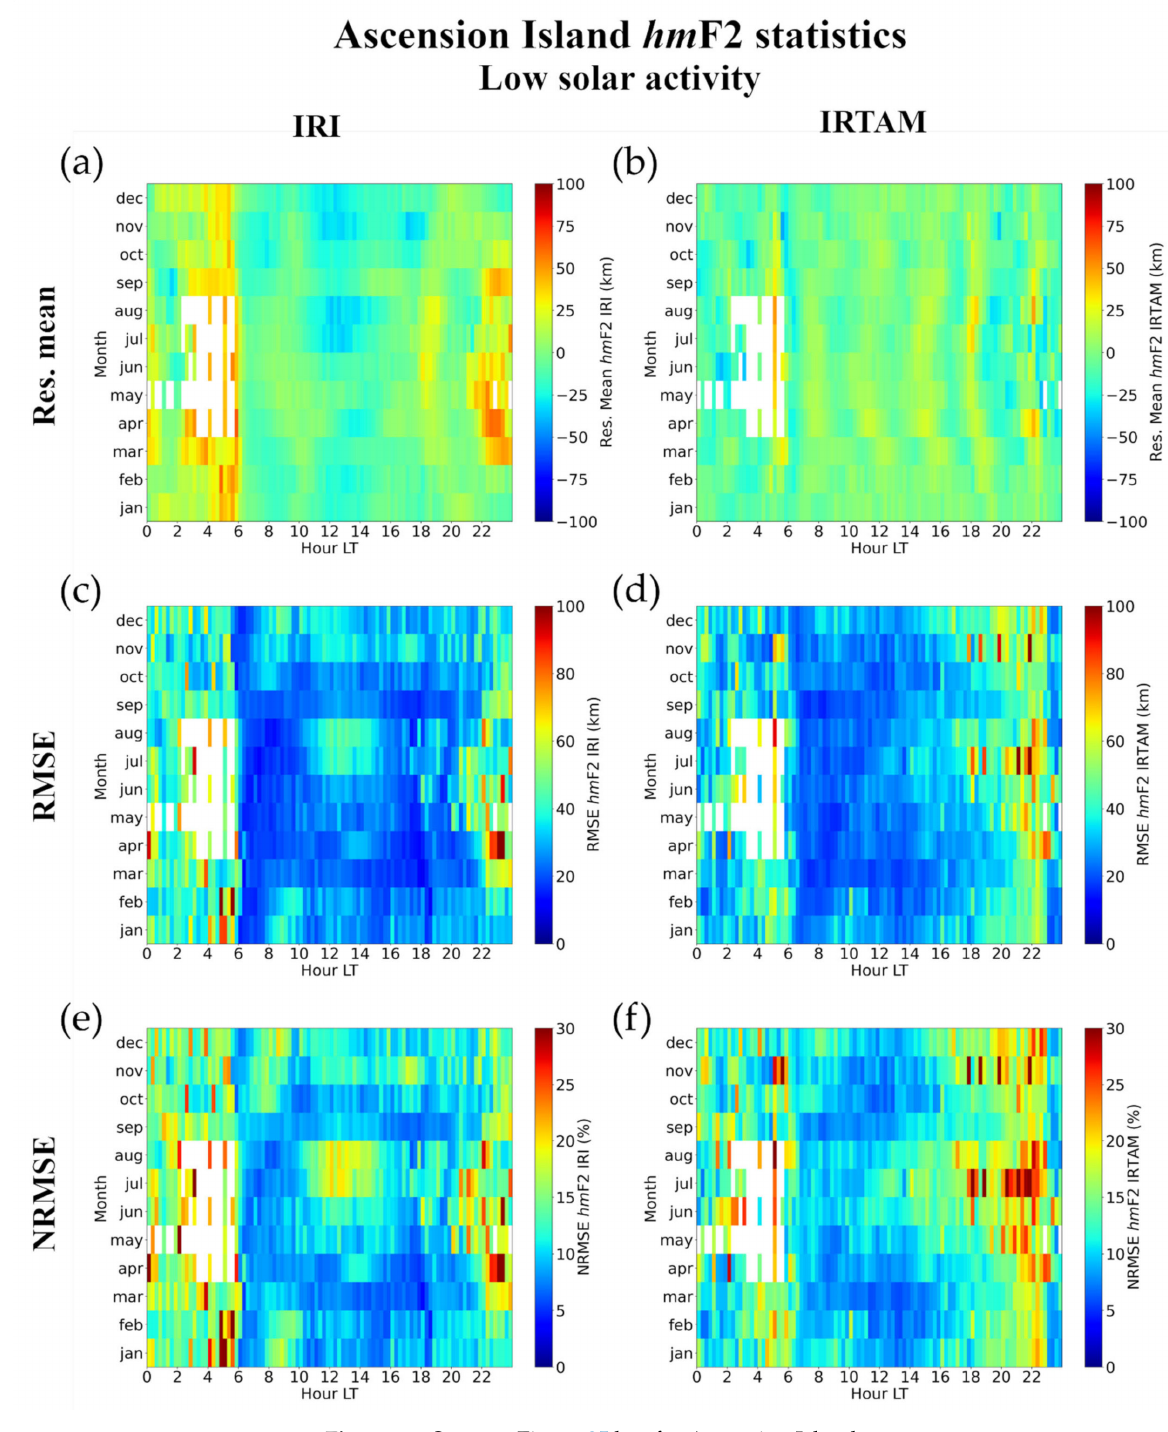
Figure 28. Same as Figure 25 but for Ascension